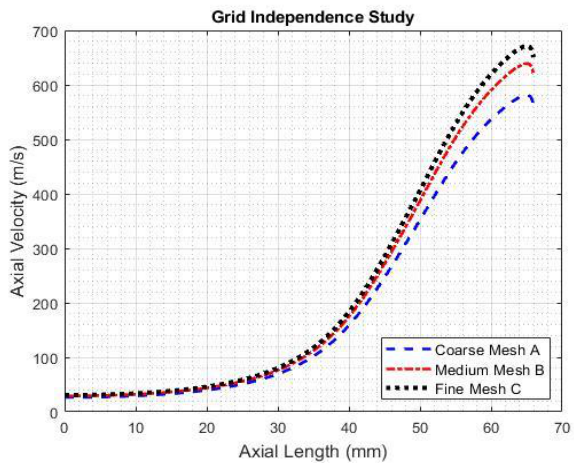
Figure 5. Grid independence study. Table 6. Gas generator design properties.